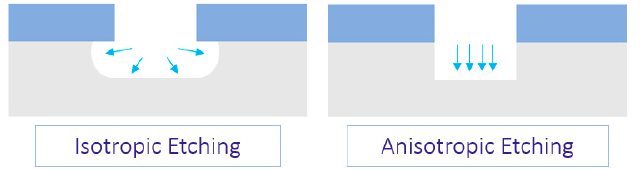
Figure 7. The isotropic and anisotropic behavior of wet- and dry-etching.